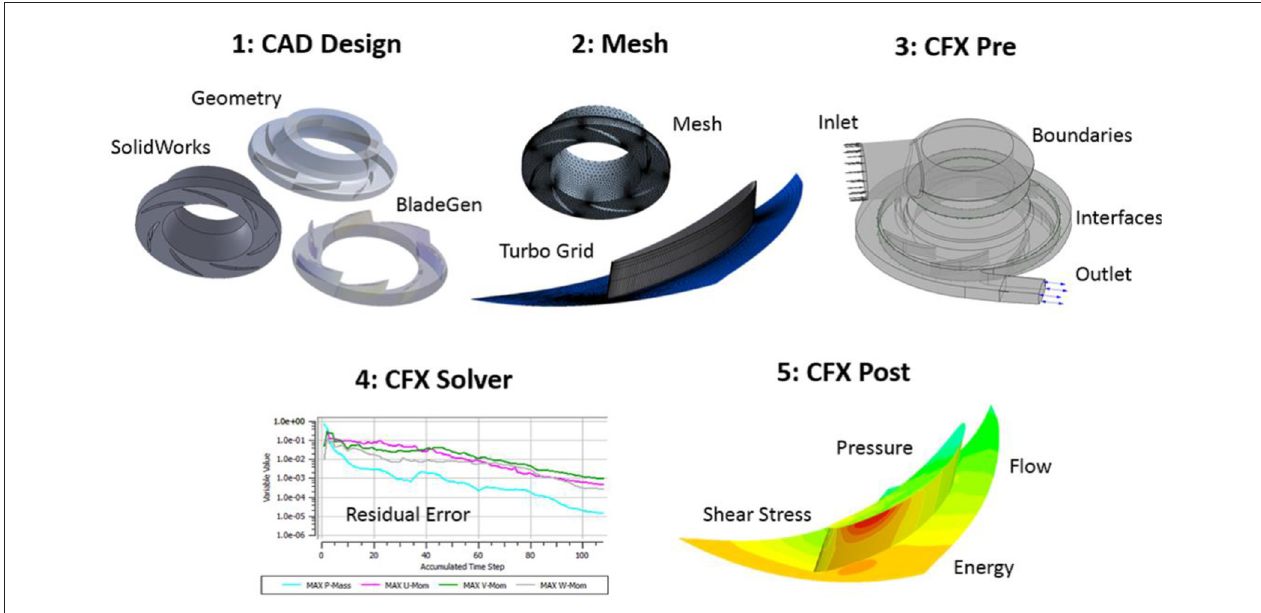
FIGURE 3 | Computational modeling approach using ANSYS CFX. (1) SolidWorks CAD design of the pump, (2) ANSYS meshing of pump regions, (3) ANSYS CFX-Pre to define physics and boundary conditions, (4) ANSYS CFX solver to complete the simulation, and (5) ANSYS CFX-post to quantify and visualize the pump performance metrics (pressure generation, fluid stress levels, velocity profiles). For CFX-post, nodal properties are exported to a Matlab code in order to estimate the blood damage index for a given operating condition. As an exemplar of the approach, a contour plot of a single bladed centrifugal impeller is